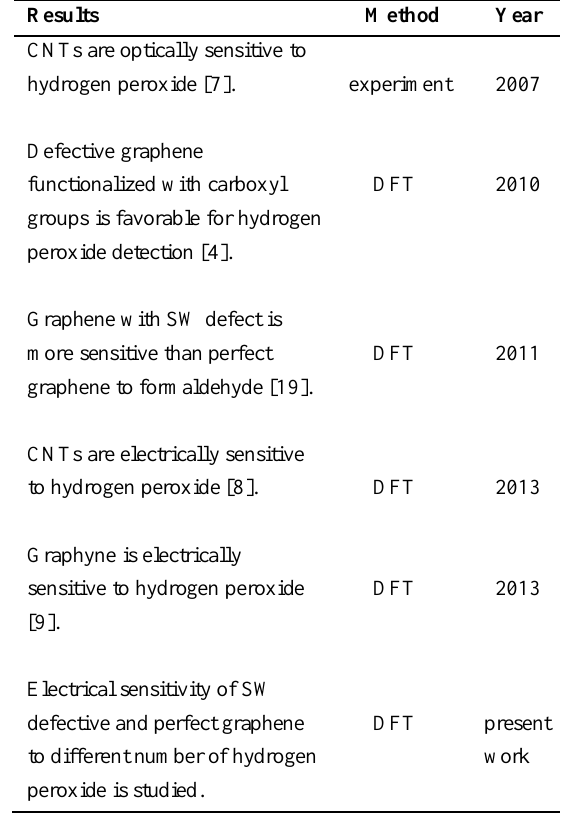
Fig. 1. Geometrical structures of (a) defect free and (b) defective